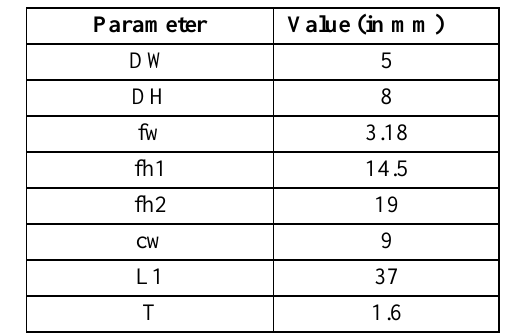
FIGURE 3. Antipodal Vivaldi antenna with parasitic patch TABLE I. Antenna Dimension